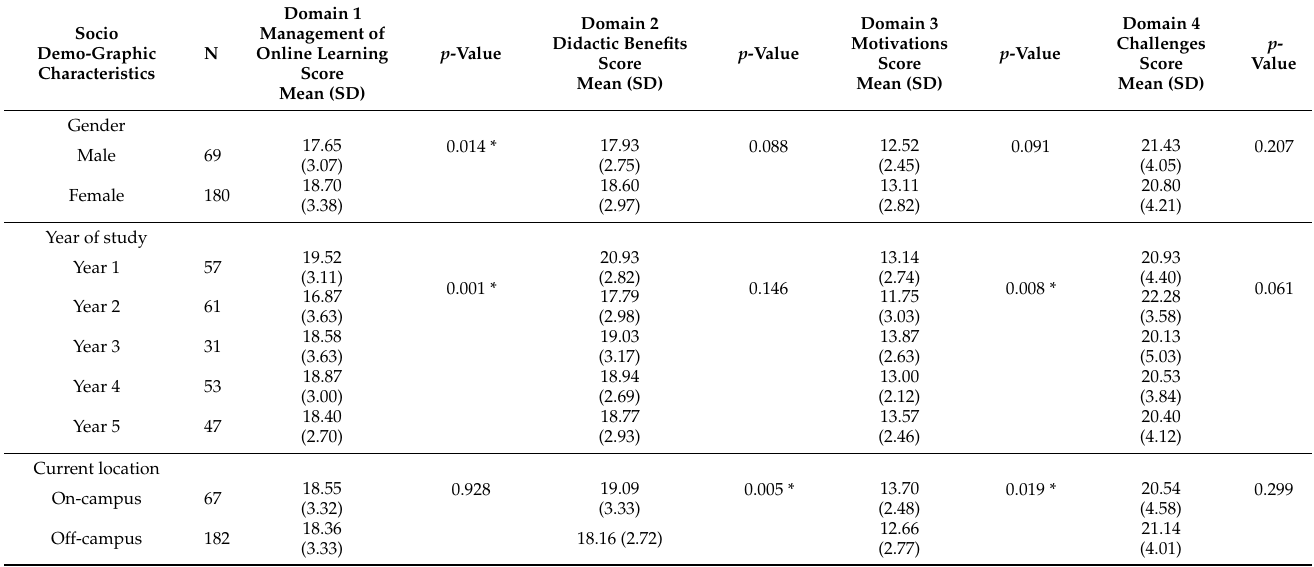
Table 2. Management of online learning, didactic benefits, motivations, and challenges scores according to the sociodemographic background of the